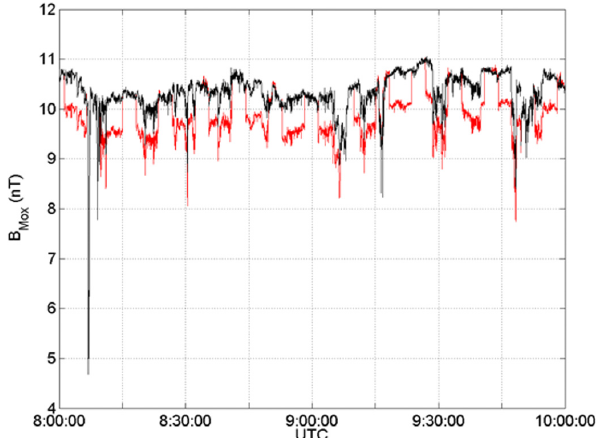
Fig. 5. A comparison of 2h of outboard sensor data from the orbit on 9 June 2006. The data is in the spacecraft co-ordinate system and has offset corrected. Red: data before correction, black: data after correction for 2 types of periodic